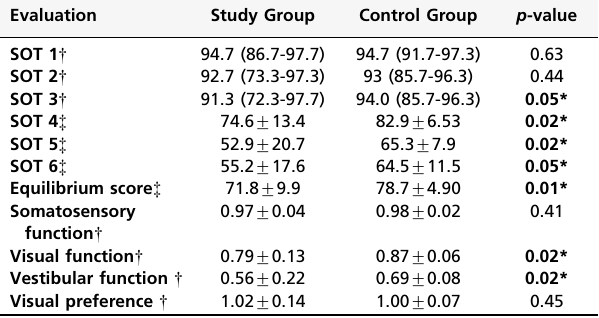
Table 2 - Posturography scores and sensory analysis in stroke patients and neurologically normal